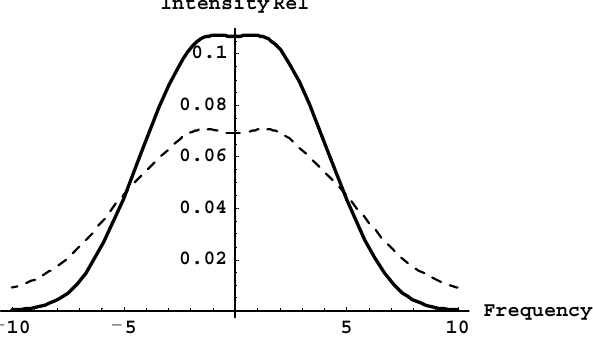
Figure 4. The profile of the Ly-beta line versus the scaled distance ∆ ω / ω from the unperturbed position of this line for the (differently) scaled amplitude ε = 3 ħ E 0 /(2Z r m e e ω ) = 1 and the scaled distance b = L/ λ = 2 of Langmuir solitons in the sequence (solid line). Also shown is the corresponding profile for the case of the non-solitonic Langmuir waves for the same value of ε = 1 (dashed line). The direction of the observation is perpendicular to vector E 0 .